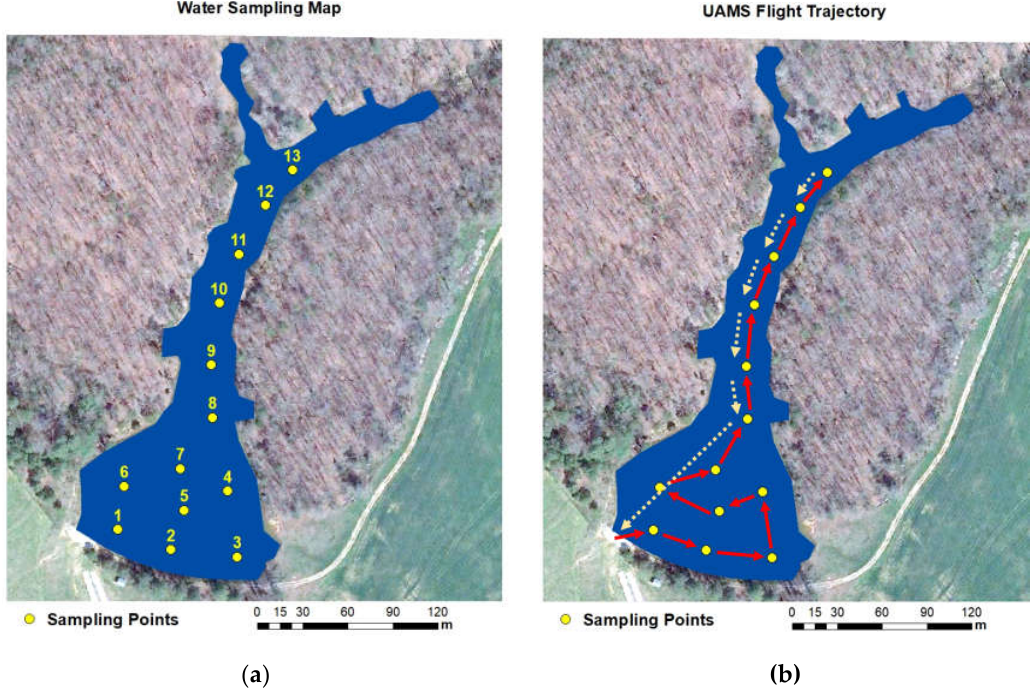
Figure 5. Satellite images from Google (maps.google.com). ( a ) UAMS sampling waypoints; ( b ) Complete flight mission trajectory at Lamaster Pond, Clemson, SC. The dashed arrows on ( b ) indicate the flight path from the last waypoint to the home location.